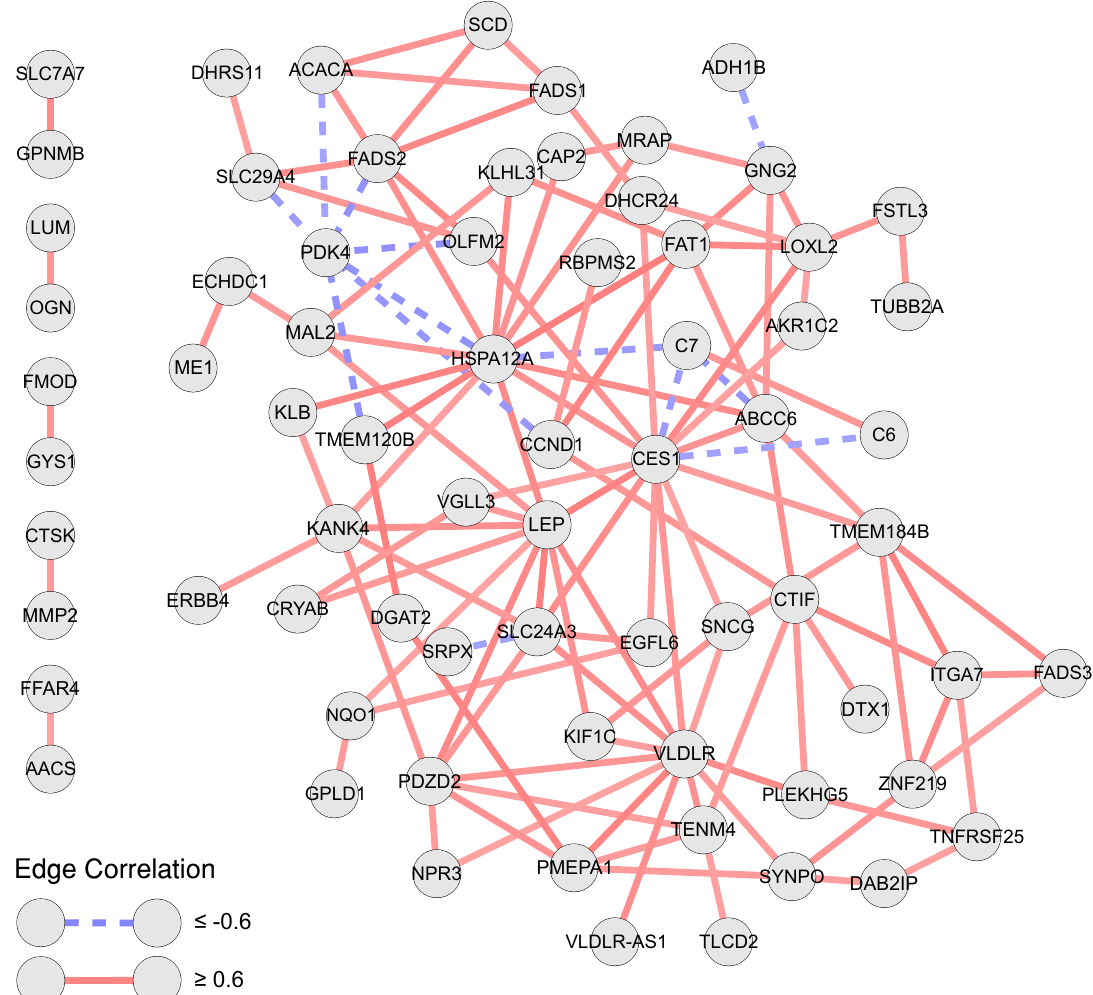
Figure 3. Overlap network showing the intersection of the edges of the low calorie diet (LCD) and the very low calories diet (VLCD) correlation networks. The intersection only depends on the sign/direction of the correlation (positive or negative), and not the exact value of the